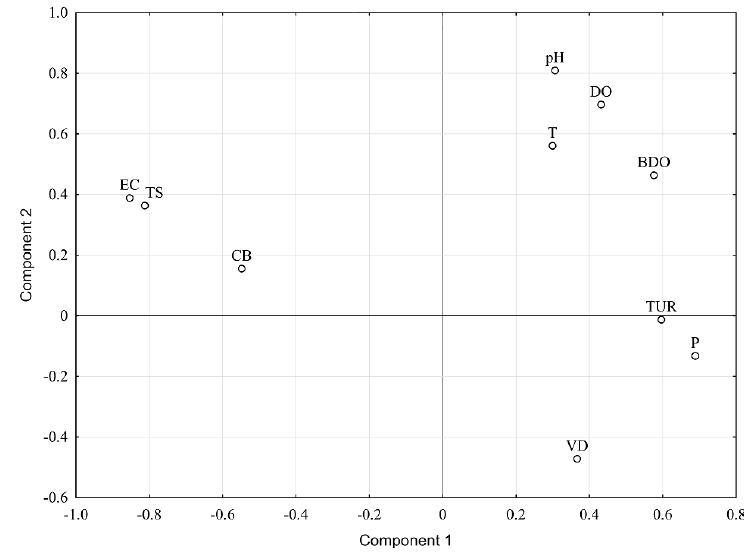
Figure 3. Weights of principal components plotted on the PC1 × PC2 plane.